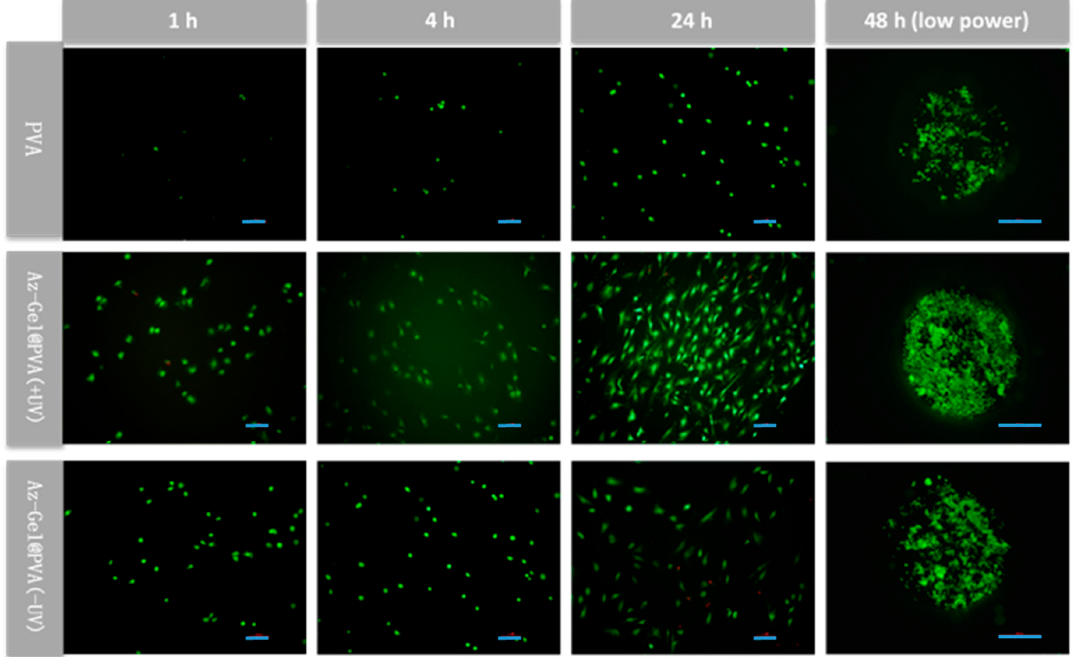
Figure 4. Fluorescence micrographs of live-dead staining of ADSCs on the different dressings after 1, 4, 24 and 48 h culture using Calcein-AM (Cal-AM) for live cells (green) and propidium iodide (PI) for dead ones(red). Scale bar lengths at 2, 4 and 24 h are 100 µ m, while scale bar length at 48 h is 500 µ